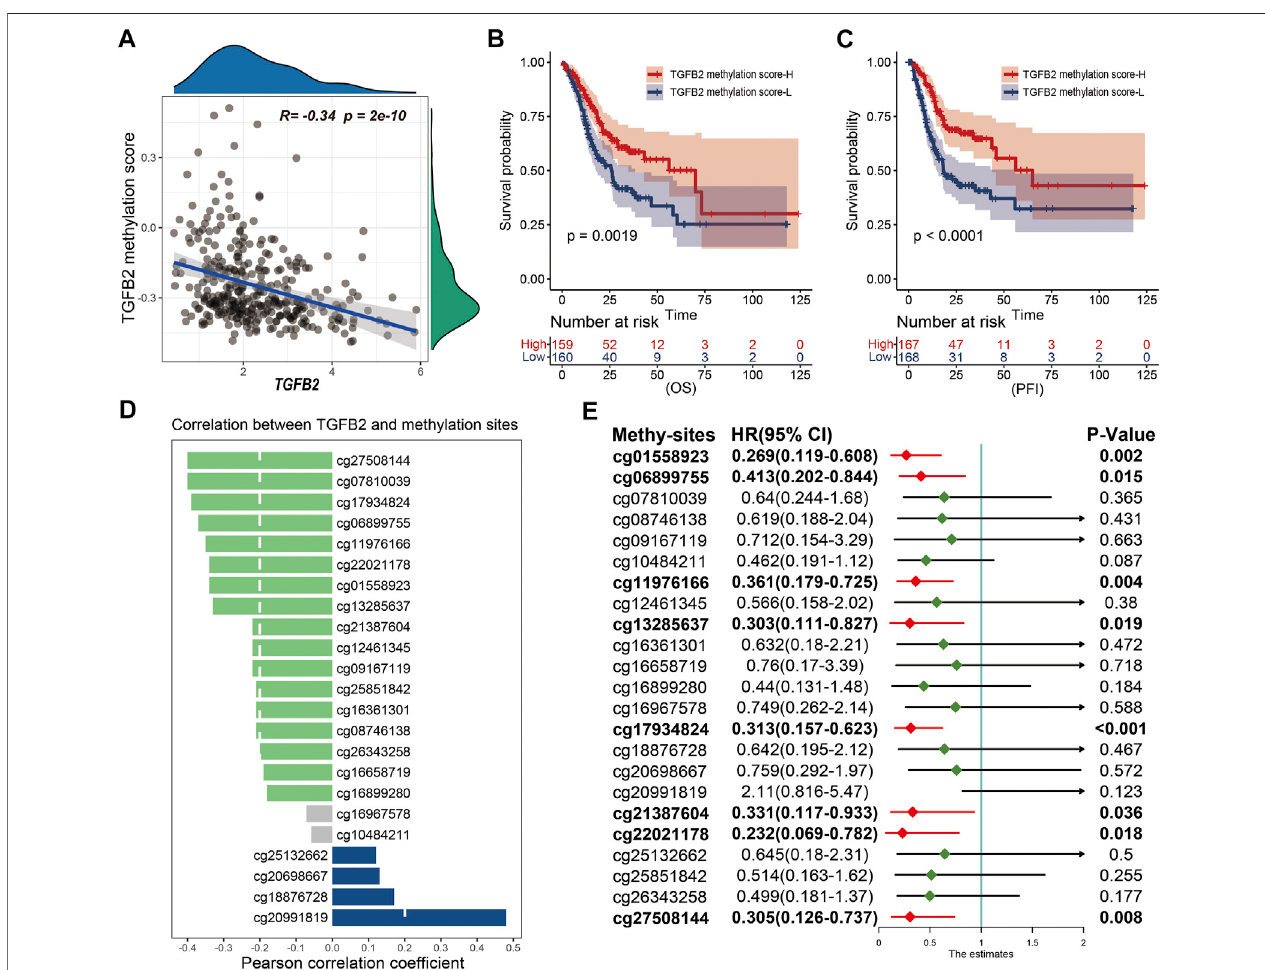
FIGURE 3 | TGF β 2 methylation score. (A) Correlation between TGF β 2 methylation score and TGF β 2 expression. Kaplan-Meier survival analysis of TGF β 2 methylation score in OS (B) and PFI (C) . (D) Correlation of TGF β 2 with methylation sites, and the column color represents the correlation of the difference, no statistical signi fi cance in gray. (E) Prognostic analysis of TGF β 2 methylation sites. HR < 1.0 (Red) indicates that the methylation site is a favorable prognostic marker.